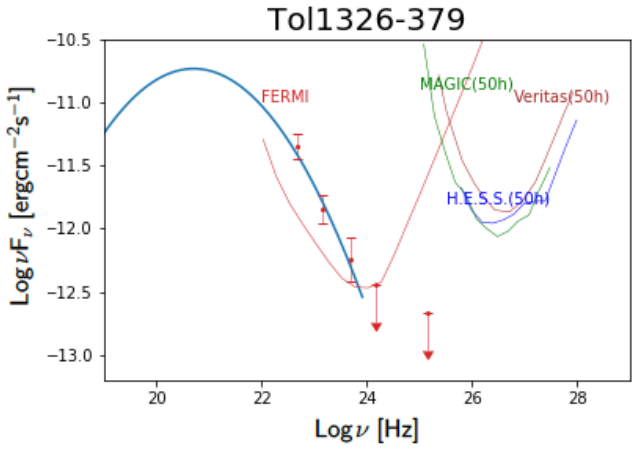
Figure 5. SED of Tol 1326-379 in the high energy band. The red points are Fermi-LAT measurements (with the corresponding sensitivity curve) fitted by a power-law component that reproduces the inverse Compton bump. We plot the expected differential sensitivity curves for 50 h of exposure of MAGIC (in green) [91], VERITAS (in brown) [92] and H.E.S.S telescopes (in blue)